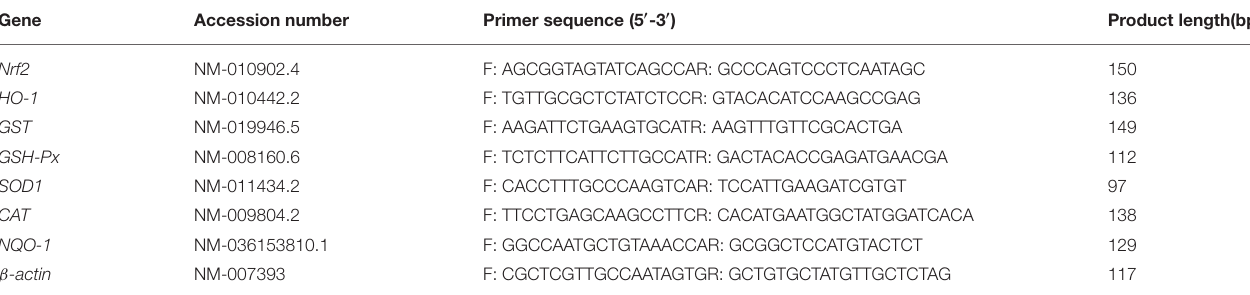
TABLE 1 | Primers used in